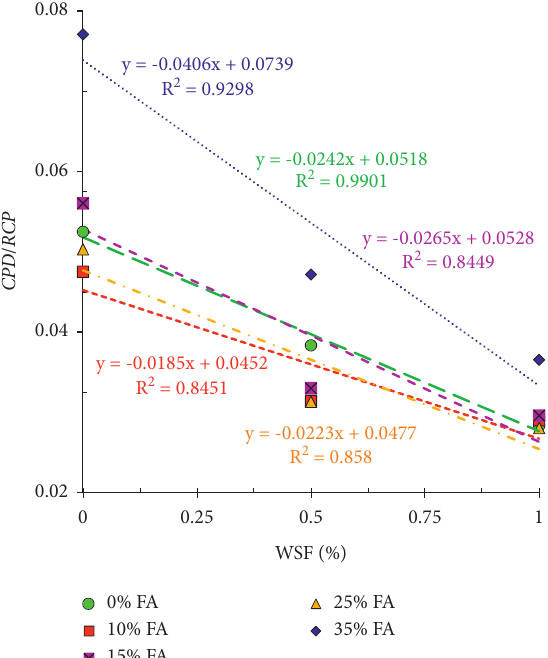
Figure 24: Relationship between CPD, RCP, and WSF content of WSF for each level of FA.